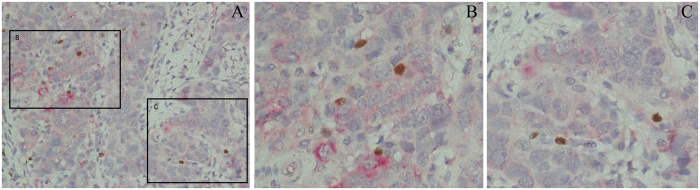
CCL20 tumor-secreted by HCC cells may contribute to the enrichment of Tregs in the tumor tissue.Immunohistochemistry double stain visualized CCL20 in cell cytoplasm (red) and FOXP3 in nucleus (brown). As shown in (B,C), the main FOXP3+ Tregs assemble in CCL20 high-express area and FOXP3+ Tregs were much fewer in CCL20 low-express area. CCL20 = chemokine ligand 20; HCC = hepatocellular carcinoma; FOXP3 = Forkhead/Winged Helix Transcription Factor P3.